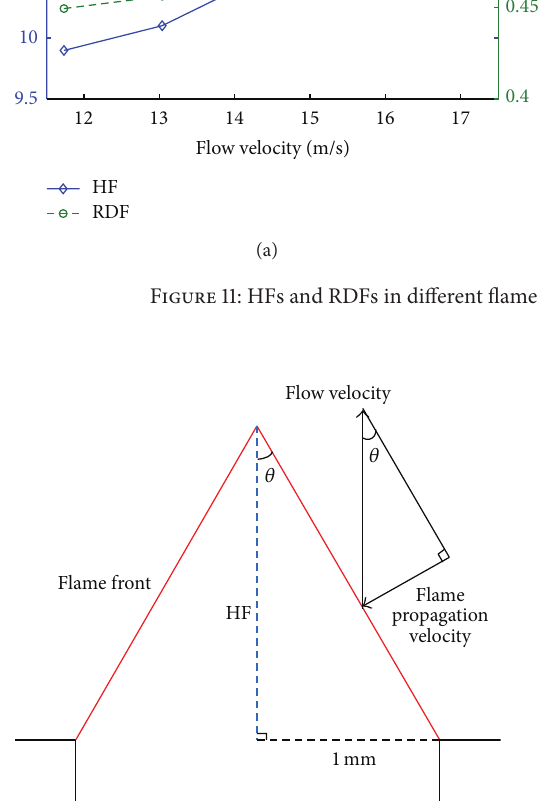
Figure 12: Geometric relationships of the flame structure and the